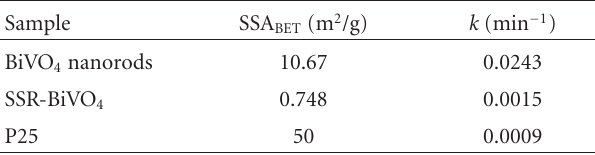
Table 1: BET SSA and reaction rate constant k of mesoporous BiVO 4 , nanorods, SSR-BiVO 4 and P25,